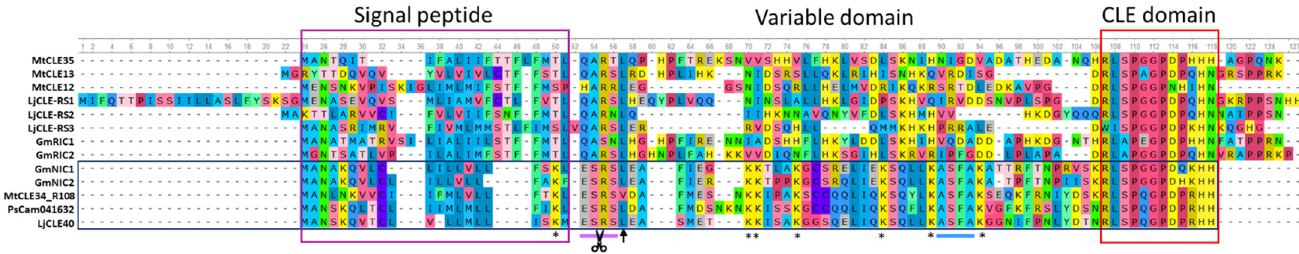
Figure 5. The alignment of amino acid sequences of nodulation-related CLE proteins from M.truncatula , L.japonicus , and G.max . PsCam041632 is included in the alignment as the closest homolog of MtCLE34 in pea. The group of NIC-like CLEs are enclosed by a box. N-terminal signal peptide is marked with a purple box, CLE domain is marked with a red box. Putative cleavage site is underlined and is shown with scissors symbol. Signal peptide and putative cleavage site position were determined using SignalP-5.0 [28]. Regions with sequence similarity among NIC-like CLEs are underlined. Lys residues that are conservative in the NIC-like CLE proteins are marked with asterisks. Arrow indicates non-conservative position in the MtCLE34 protein from the R108 line.